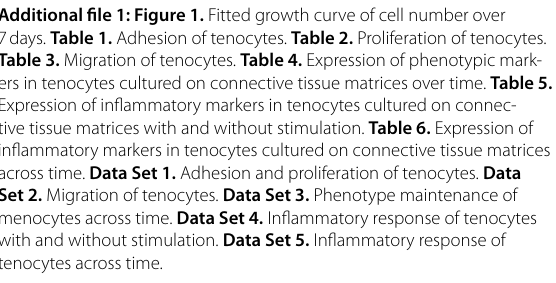
Table 3. Migration of tenocytes. Table 4. Expression of phenotypic mark- ers in tenocytes cultured on connective tissue matrices over time. Table 5. Expression of inflammatory markers in tenocytes cultured on connec- tive tissue matrices with and without stimulation. Table 6. Expression of inflammatory markers in tenocytes cultured on connective tissue matrices across time. Data Set 1. Adhesion and proliferation of tenocytes. Data Set 2. Migration of tenocytes. Data Set 3. Phenotype maintenance of menocytes across time. Data Set 4. Inflammatory response of tenocytes with and without stimulation. Data Set 5. Inflammatory response of tenocytes across